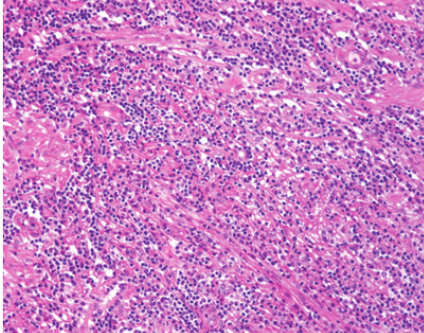
Figure 1: Low power view of IgG4-related prostatitis. The prostatic stroma shows a dense inflammatory infiltrate and fibrosis (H&E, 100x).